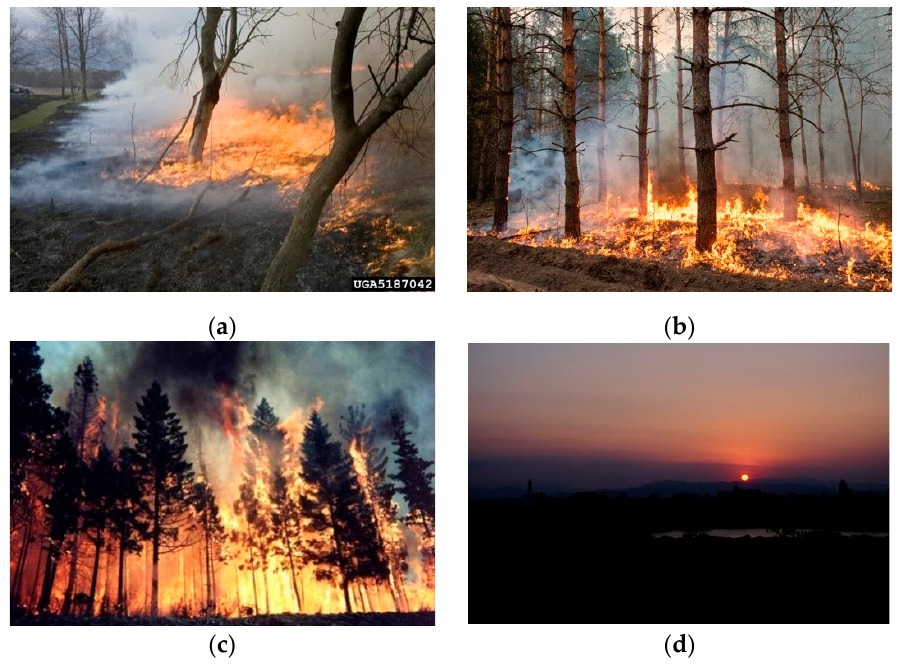
Figure 1. Representative images from the forest fire data set including ( a ) ground fires ( b ) ground fires ( c ) trunk fires, and ( d ) sun distractor.